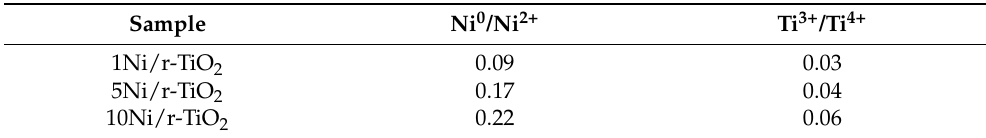
Figure 5. ( A ) Ni 2p and ( B ) Ti 2p XPS spectra of 650 ◦ C-reduced 1Ni/r-TiO 2 , 5Ni/r-TiO 2 , and 10Ni/r-TiO 2 . Table 3. The XPS-derived Ni 0 /Ni 2+ and Ti 3+ /Ti 4+ ratios.